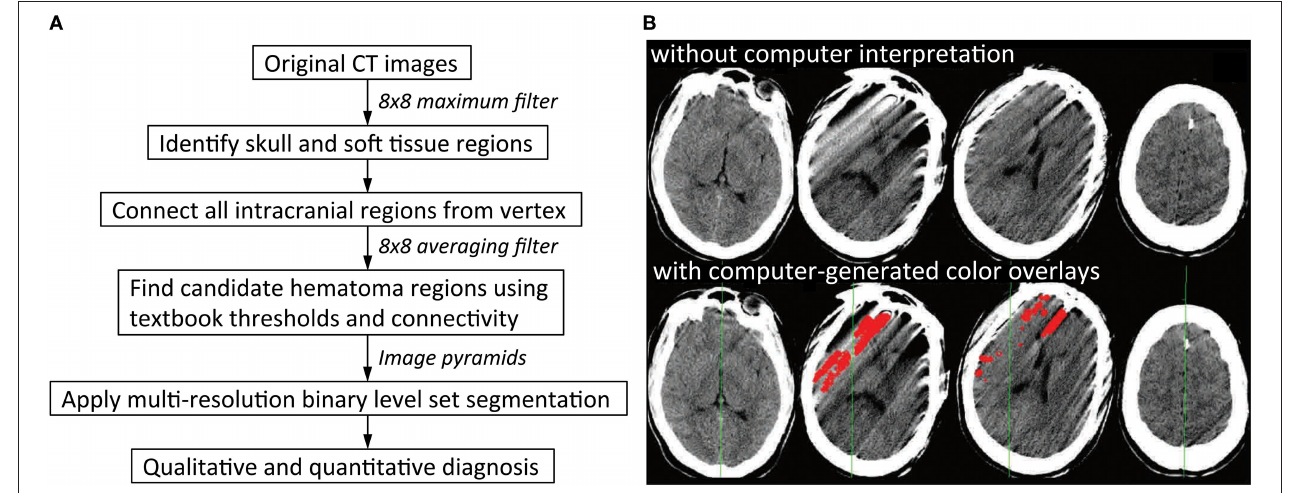
FIGURE 2 | Rule-based algorithms. (A) Illustrates one possible workflow for a rule-based intracranial hemorrhage detection model. Application of thresholding and connectivity is a common way to identify regions of hematoma (8). (B) Shows examples of false positive errors from rule-based models in which streak artifacts are incorrectly labeled as regions of intracranial hemorrhage. This can result if regions of hemorrhage are obtained by thresholding for brighter pixels, which is a common strategy in rule-based models. Red indicates regions of algorithmic predictions